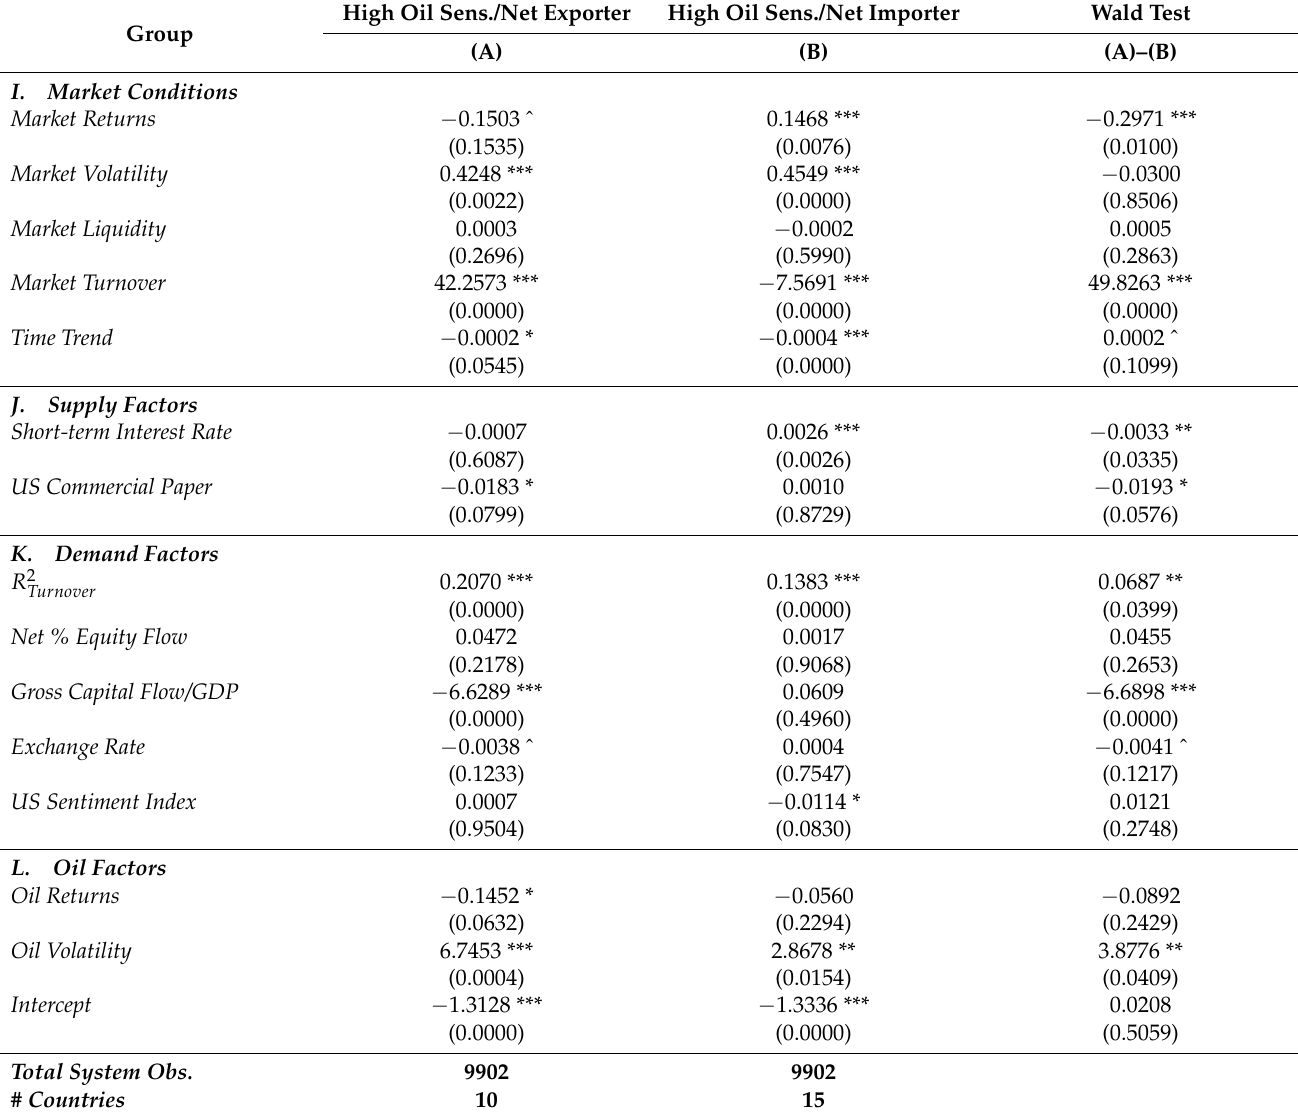
Table 6. Seemingly unrelated regressions of commonality in liquidity on sources of commonality: net exporters and net importers. This table reports the results from SUR of 50 equations, representing the number of countries in our sample. All equations are jointly estimated for the period from January 1995 to December 2015. In each model, we restricted the coefficients to be equal within each group but to vary across three groups. The first group includes the highly oil-sensitive net exporters (countries whose oil sensitivity ratio is above the median of all countries and that are net exporters), the second includes highly oil-sensitive and net importers (countries whose oil sensitivity ratio is above the median of all countries and that are net importers), and the third includes less oil-sensitive countries (countries whose oil sensitivity ratio is below the median of all countries). The third group’s results are suppressed since they are presented in Table 4. The dependent variable is a log-transformed form of the commonality in liquidity measure, R 2 . Full definitions of all variables are Amihud presented in Table A1 in Appendix A. In the last two columns, the Wald test is reported for the difference in the coefficients between